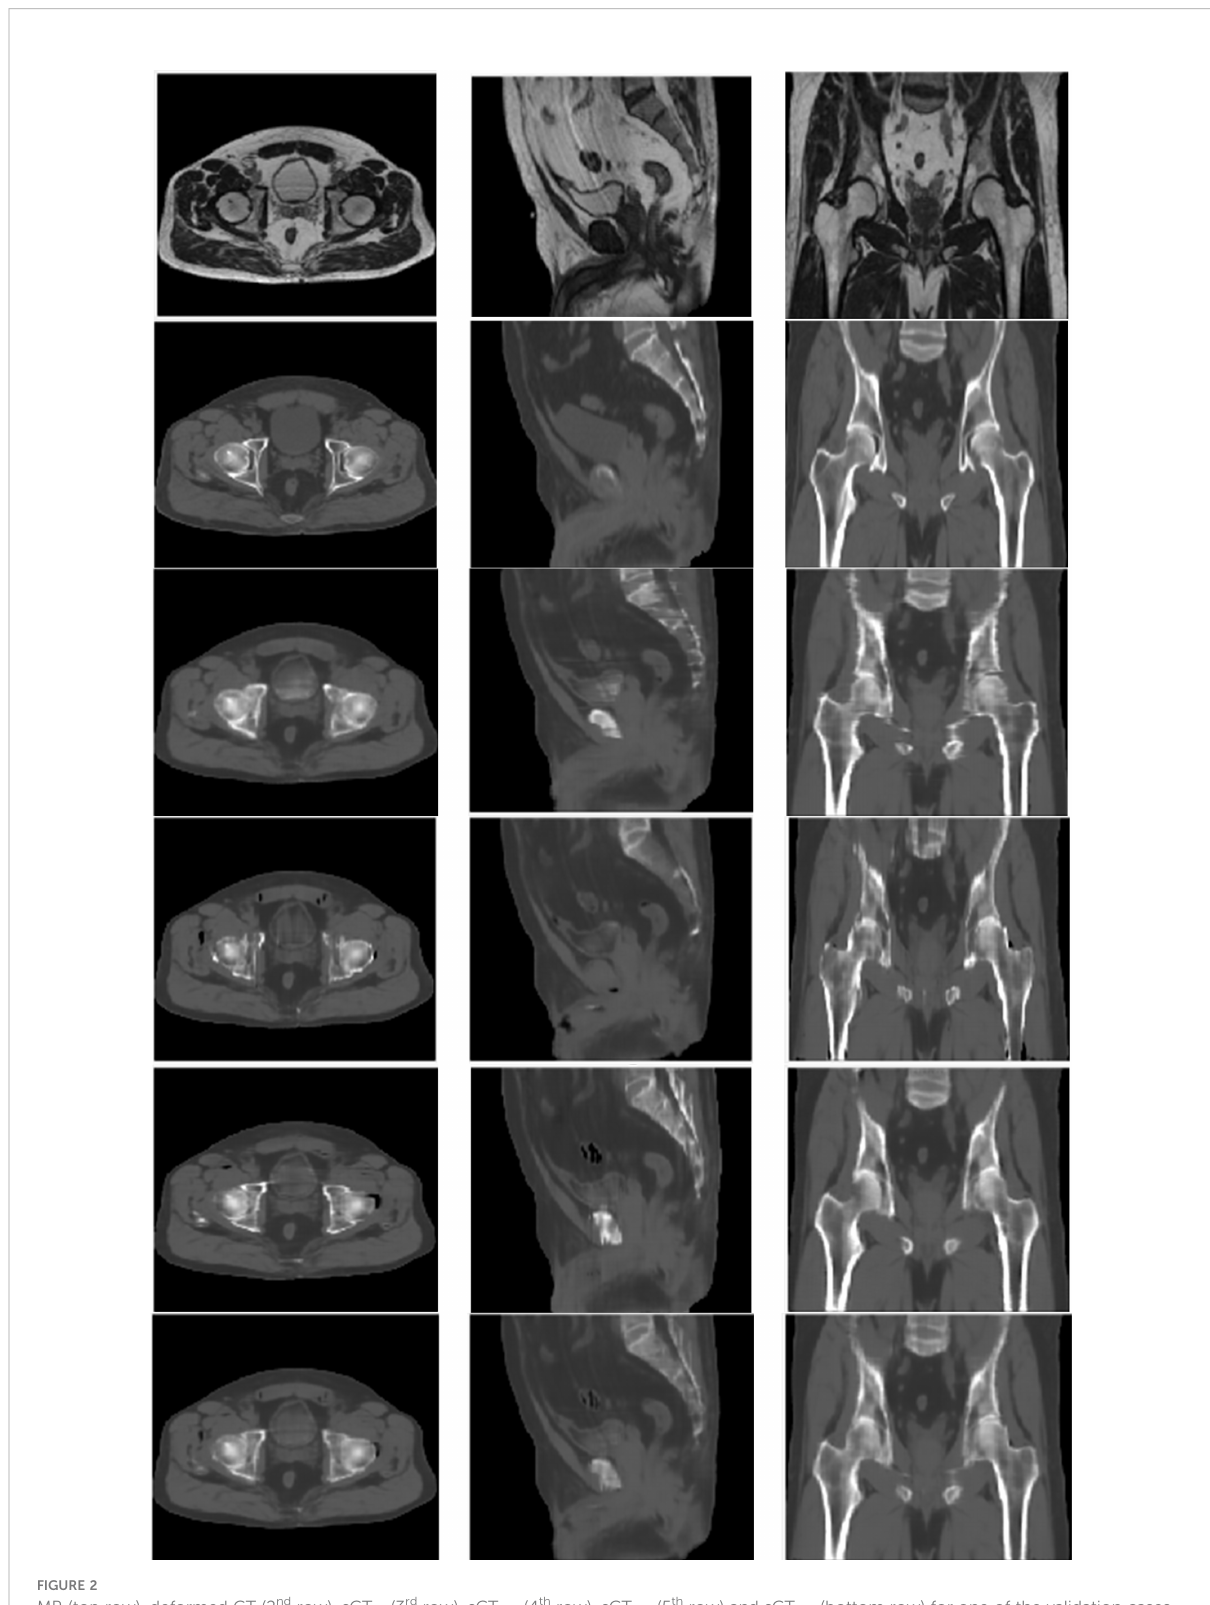
FIGURE 2 MR (top row), deformed CT (2 nd row), sCT ax (3 rd row), sCT sag (4 th row), sCT cor (5 th row) and sCT ave (bottom row) for one of the validation